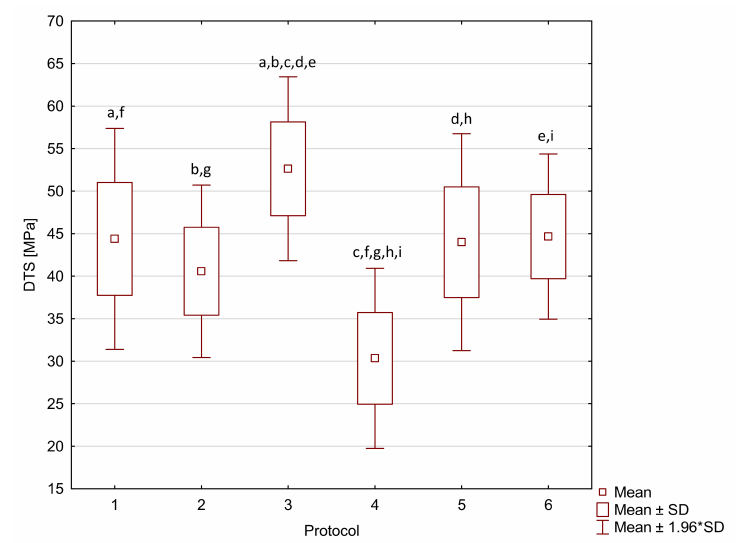
Figure A8. Box-and-whisker plot of diametral tensile strength (DTS) of Arkon material. Statistically- significant differences were detected between the following: (a,b,c,d,e) Protocol 3 (water, 500 ther- mocycles, 5/55 ◦ C) vs. (a) Protocol 1 (water, 24 h, 37 ◦ C) ( p = 0.003699); (b) Protocol 2 (artificial saliva, 90 days, 37 ◦ C) ( p = 0.000049);(c) Protocol 4 (water, 7500 thermocycles, 5/55 ◦ C) ( p = 0.00000); (d) Protocol 5 (0.1 M NaOH, 7 days, 60 ◦ C) ( p = 0.002486); (e) Protocol 6 (water, 5 days, 55 ◦ C) ( p = 0.004921); (f,g,h,i) Protocol 4 (water, 7500 thermocycles, 5/55 ◦ C) vs. (f) Protocol 1 (water, 24 h, 37 ◦ C) ( p = 0.000004); (g) Protocol 2 (artificial saliva, 90 days, 37 ◦ C) ( p = 0.000422); (h) Protocol 5 (0.1 M NaOH, 7 days, 60 ◦ C) ( p = 0.000007); (i) Protocol 6 (water, 5 days, 55 ◦ C) ( p = 0.000003).